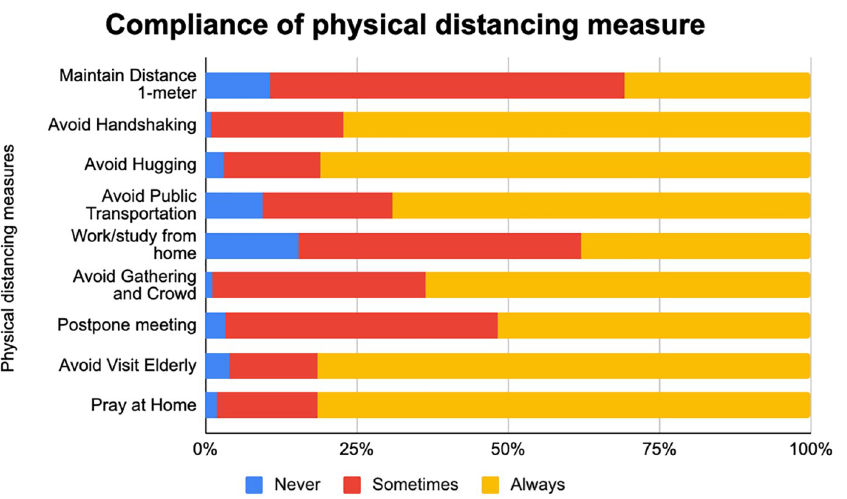
Fig 1. A graph of compliance among young adults for each physical distancing